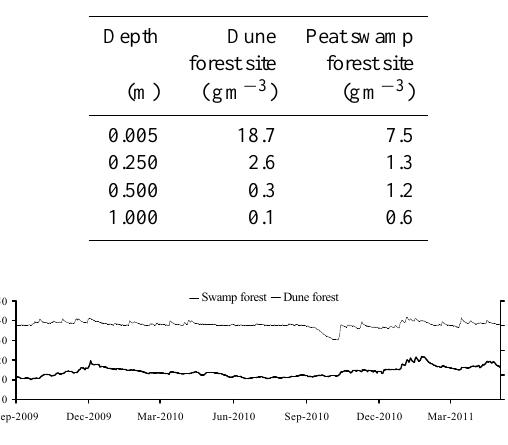
Fig. 5. Total volumetric water content in the upper 1.5m of the soil profile at the dune forest and peat swamp forest